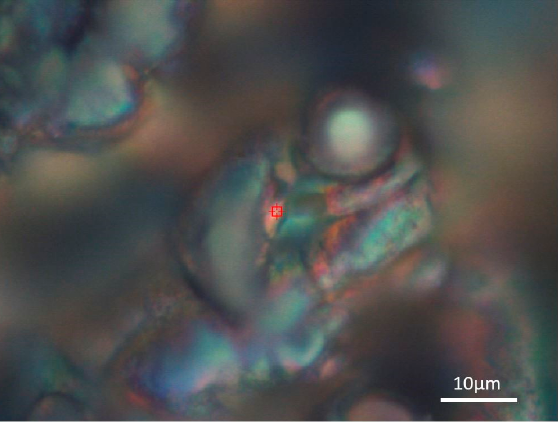
Figure 11. Detailed optical image of the red area of the laser patterned sample.